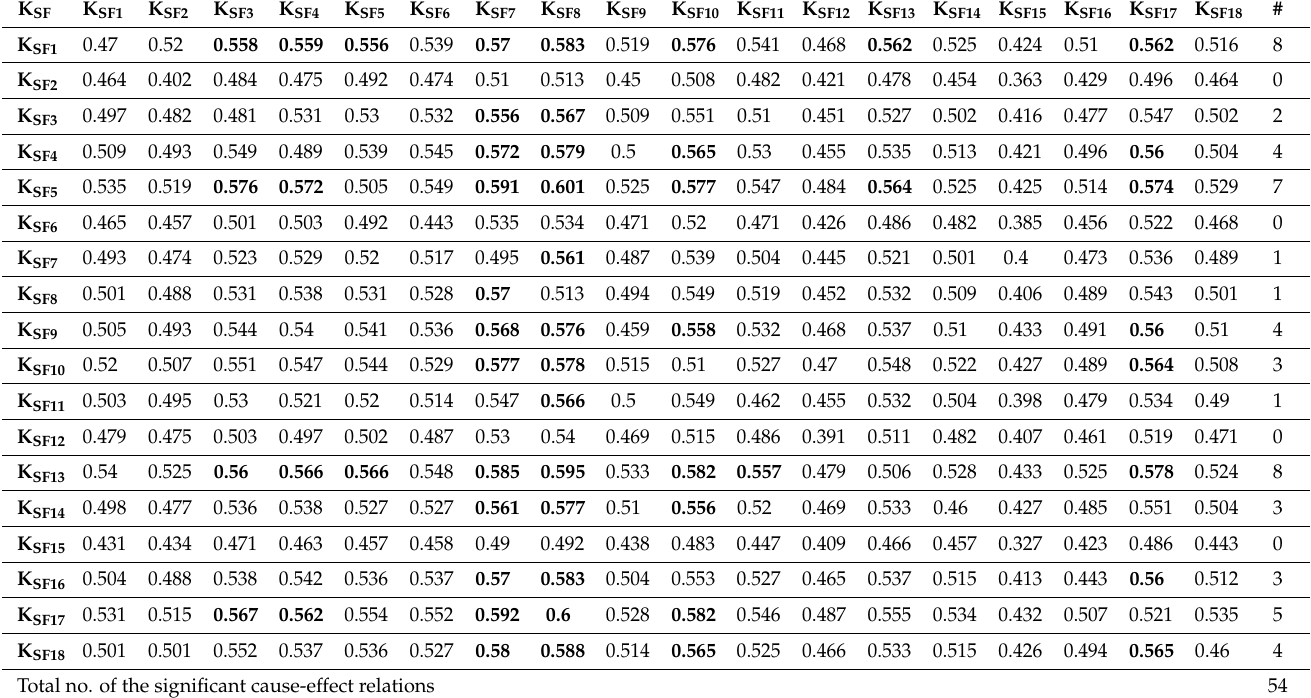
Table A4. Total-relation matrix